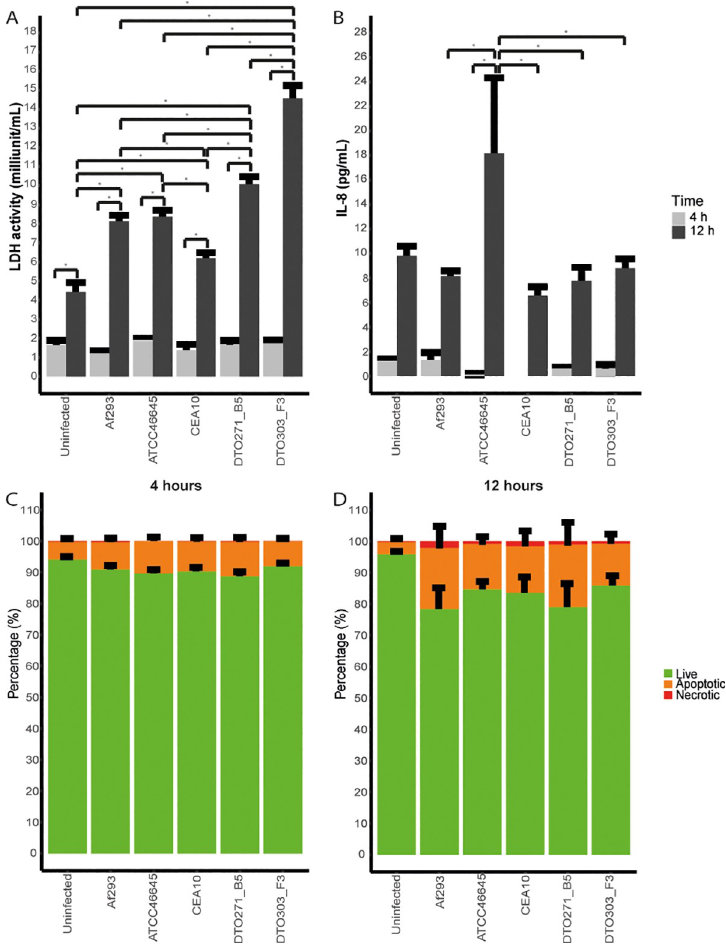
Fig 5. Host cell damage and immune response of A549 cells during confrontation with A . fumigatus . LDH release (mU mL -1 ) (A) and IL-8 production (pg mL -1 ) (B) of the A549 cells after 4 (light grey) and 12 (dark grey) h of infection. Percentage of cells which are alive (green), apoptotic (orange) or necrotic (red) after 4 (C) or 12 (D) h of infection with A . fumigatus conidia. Bars represent the average of three independent experiments ( ± SE). � indicates statistical significance, based on a one-way ANOVA with a p-value �